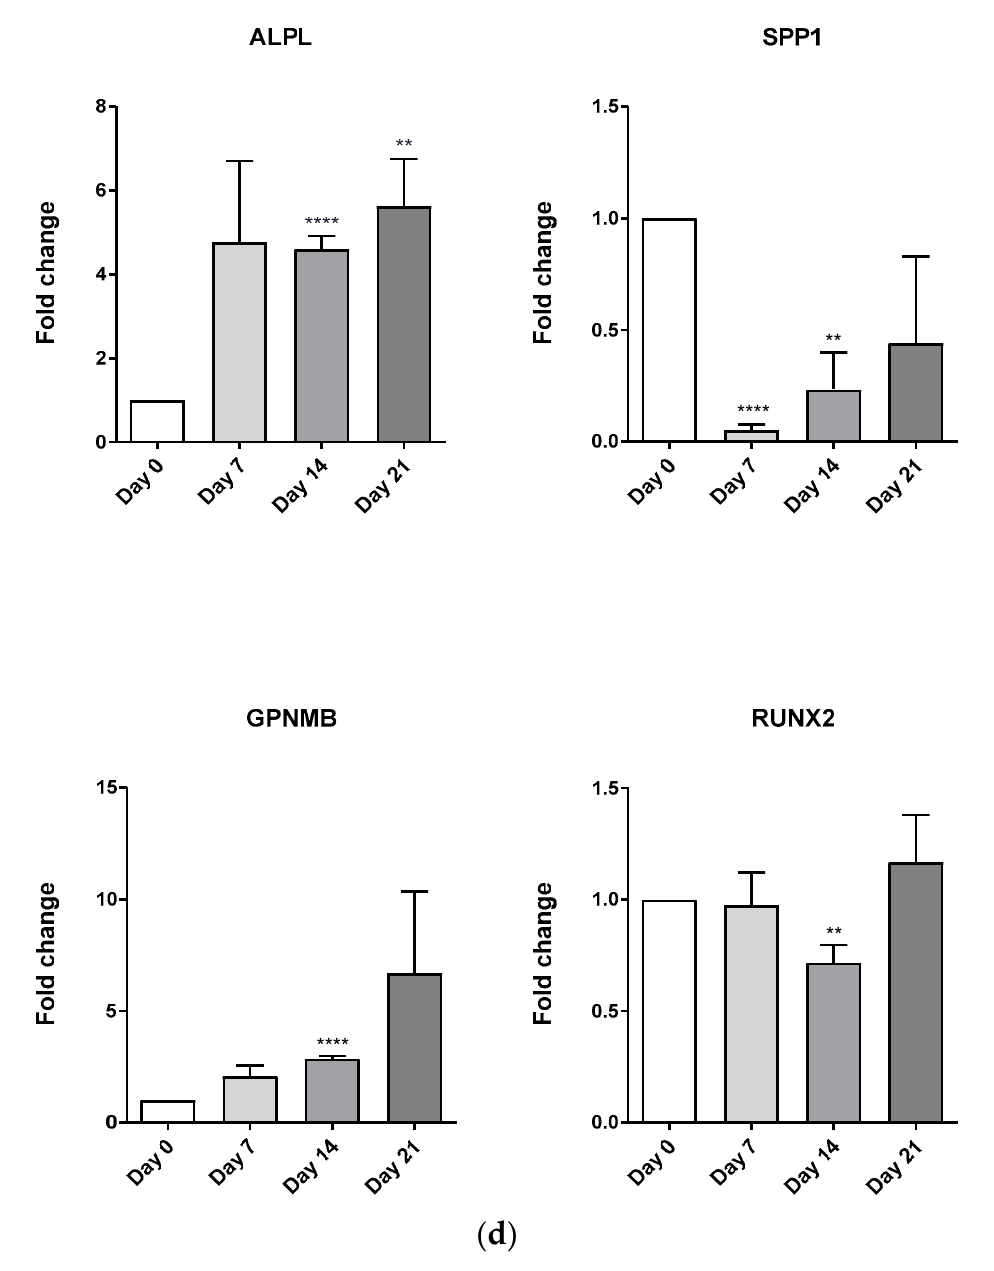
Figure 6. Osteoblastic differentiation of C3H10T1/2, and hMSC-TERT cell lines. ( a ) Differentiation of C3H10T1/2 along 21 days with lab-made medium. ( b , c ) Alizarin Red staining of C3H10T1/2, and hMSC-TERT cells differentiated during 21 days. ( d ) Differentiation of hMSC-TERT during 21 days with lab-made medium. ALPL, SPP1, GPNMB, and RUNX2 osteoblastogenic marker gene expression assessed by RT-qPCR. Data coming from at least three independent experiments are presented as fold change over D0 differentiation data and expressed as the Mean ± SEM (* p < 0,05; ** p < 0,01; *** p < 0,001; **** p < 0,00001).